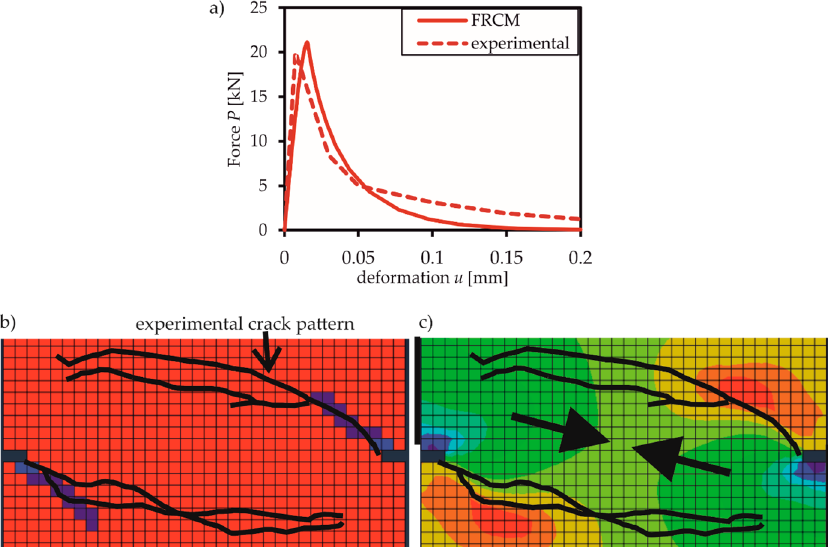
Figure 10. Illustration of ( a ) numerical force-deformation curve for load path 0, ( b ) numerical crack pattern illustrated with the damage parameter β for the elasticity modulus, and ( c ) numerical main stress condition. All were compared to the experimental results of Nooru-Mohamed [20] by using Walraven’s [13,14] aggregate interlock model.